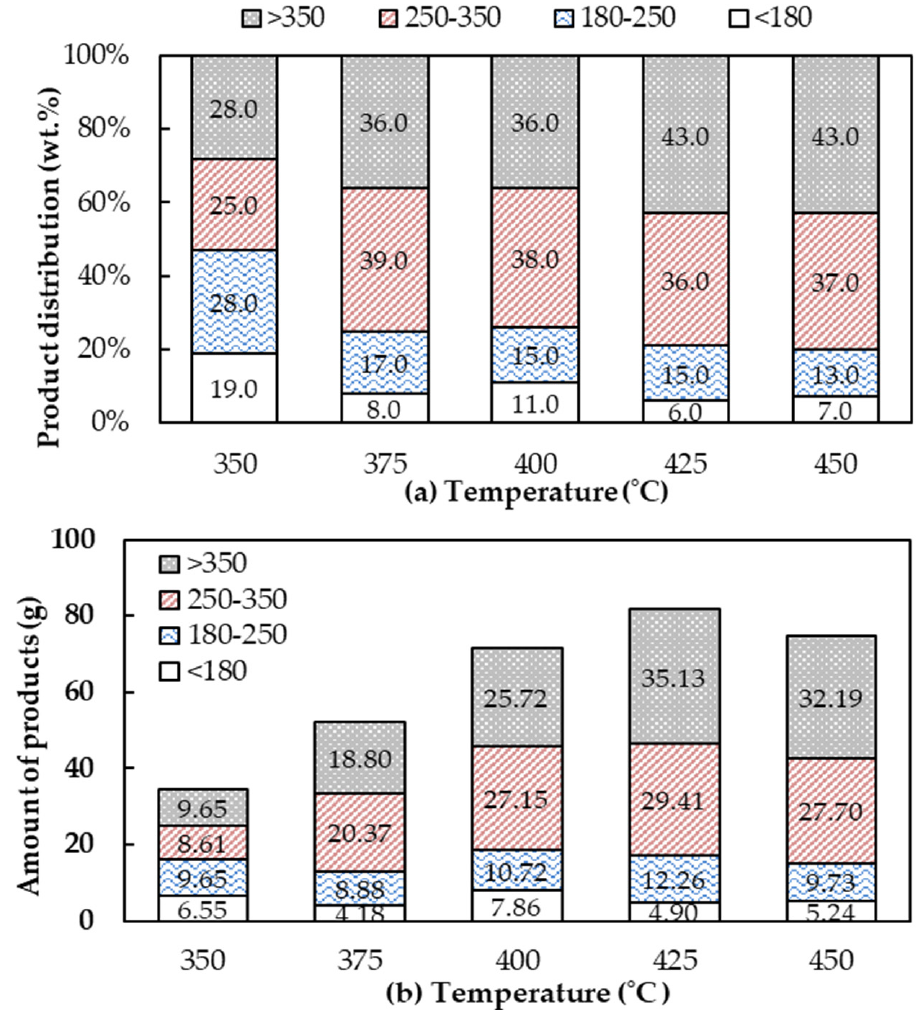
Figure 5. The boiling temperature distribution of liquid bio-oil obtained from pyrolysis. ( a ) Product distribution by percentage; ( b ) production distribution by amount. (Operating conditions: a flow rate of N 2 of 40 mL/L without a catalyst and a pyrolyzed temperature range of 350–450 °C.)